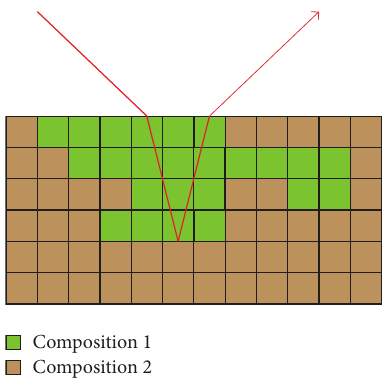
Figure 7: Multilayers reflection model.